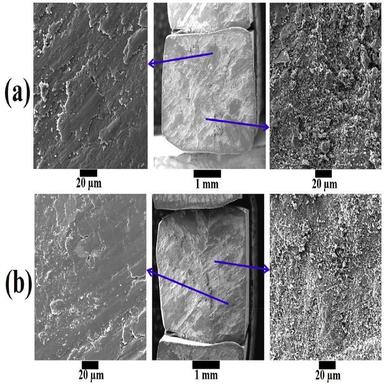
Fractographic features on the worn-out surfaces of (a) annealed and (b) FSP modified AA6061 aluminum alloys after sliding distance of 1000 m.